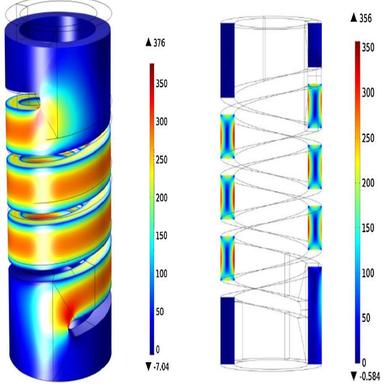
Maximum principal stress distribution in the (left) whole spring, (right) wire cross section.